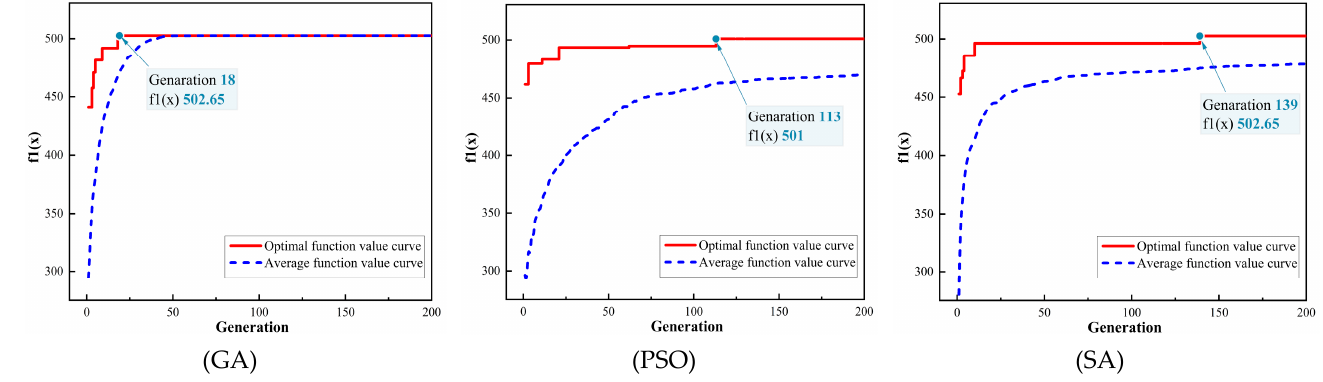
Figure 6. Average function value and optimal function value evolution curves of different algo- rithms.